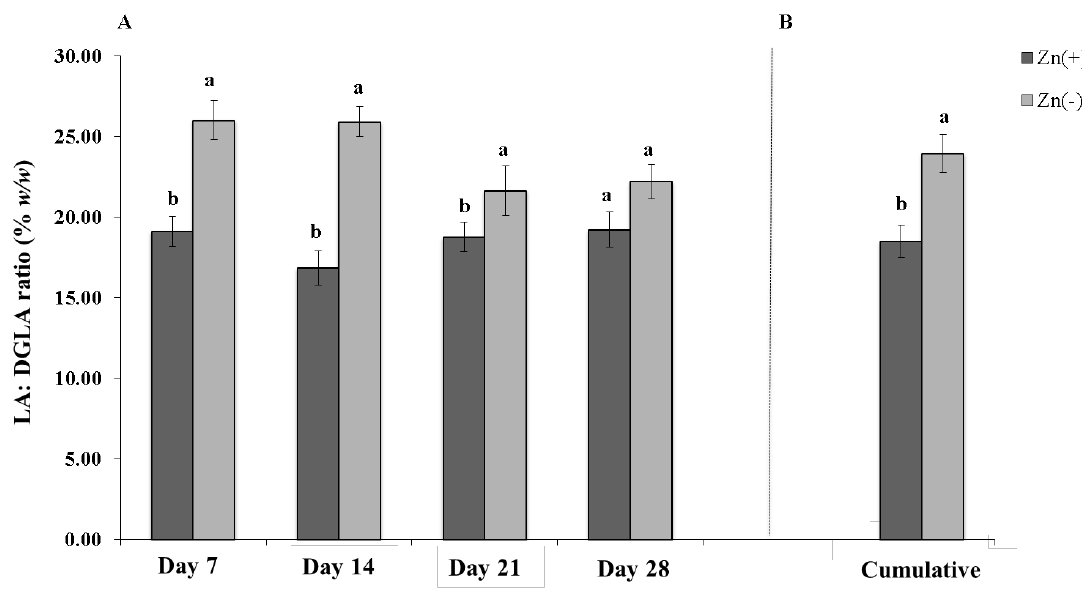
Figure 4. Chicken LA:DGLA ratio of Zn(+) control and Zn(−) groups. The LA:DGLA ratio is expressed as mass percent (% w/w). ( A ) Weekly chicken LA:DGLA ratio of Zn(+) and Zn(−) treatment groups ( n = 12). a,b Within a time point, means without a common letter are statistically significant ( p < 0.05). ( B ) Cumulative differences in LA:DGLA ratio between Zn(+) control and Zn(−) and treatment groups ( n = 12). a,b Means without a common letter are significantly different ( p <